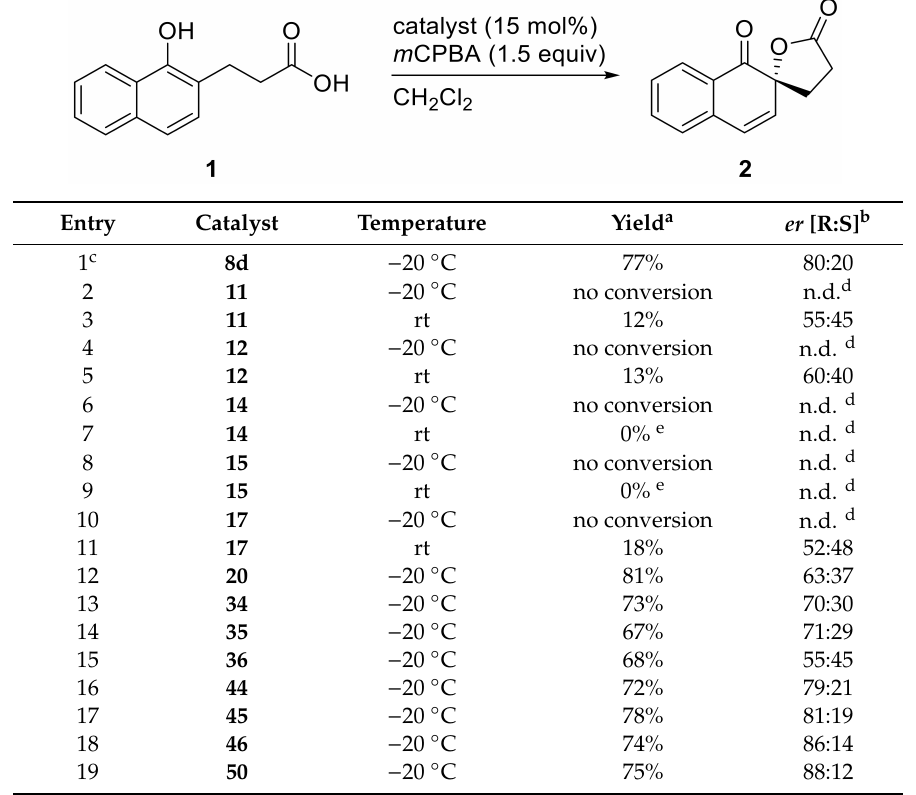
Entry Catalyst Temperature Yield